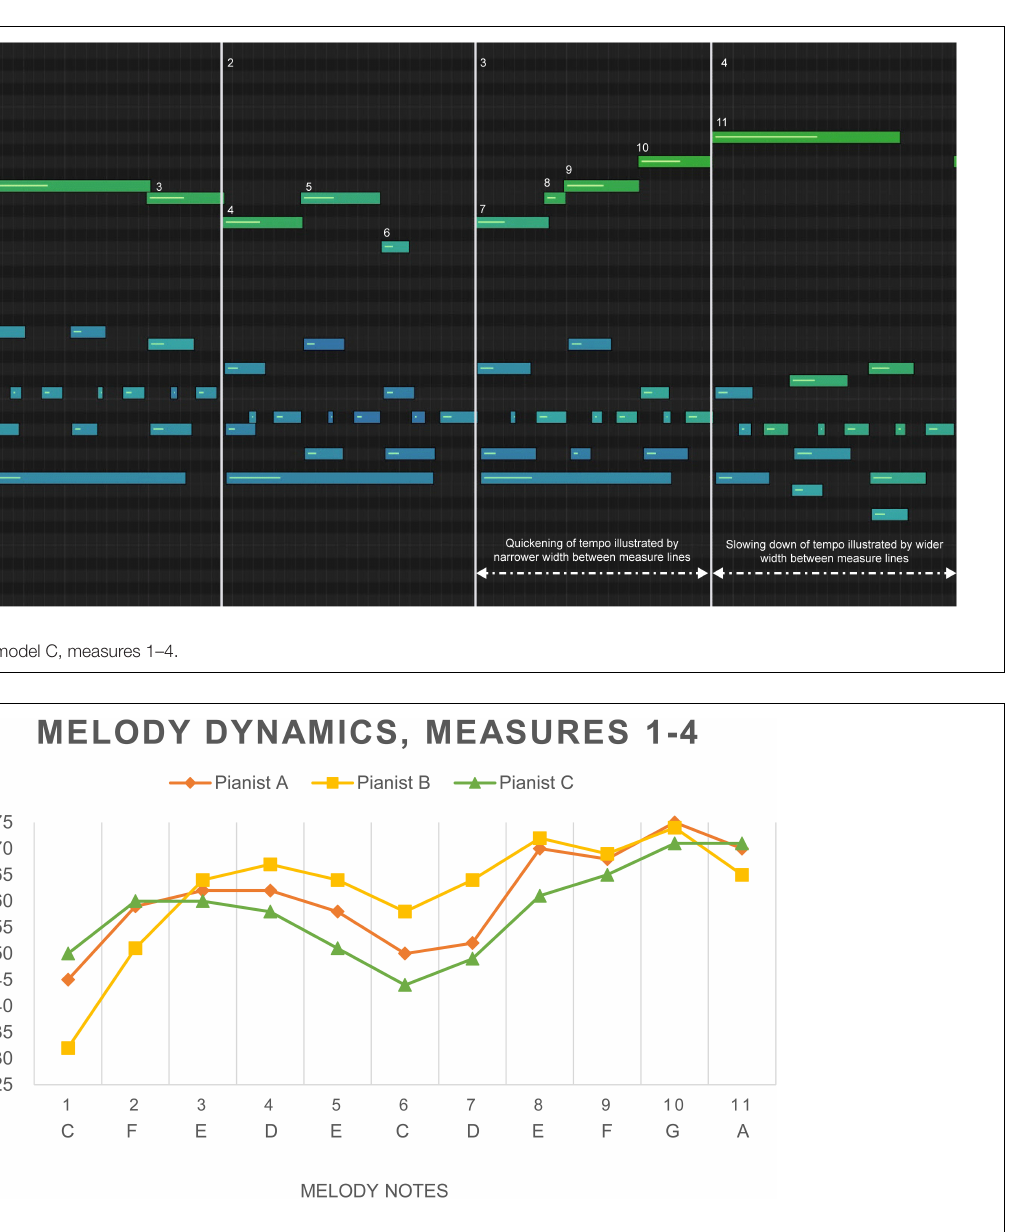
FIGURE 7 | Comparison of artists’ velocity (dynamics) melody, measures